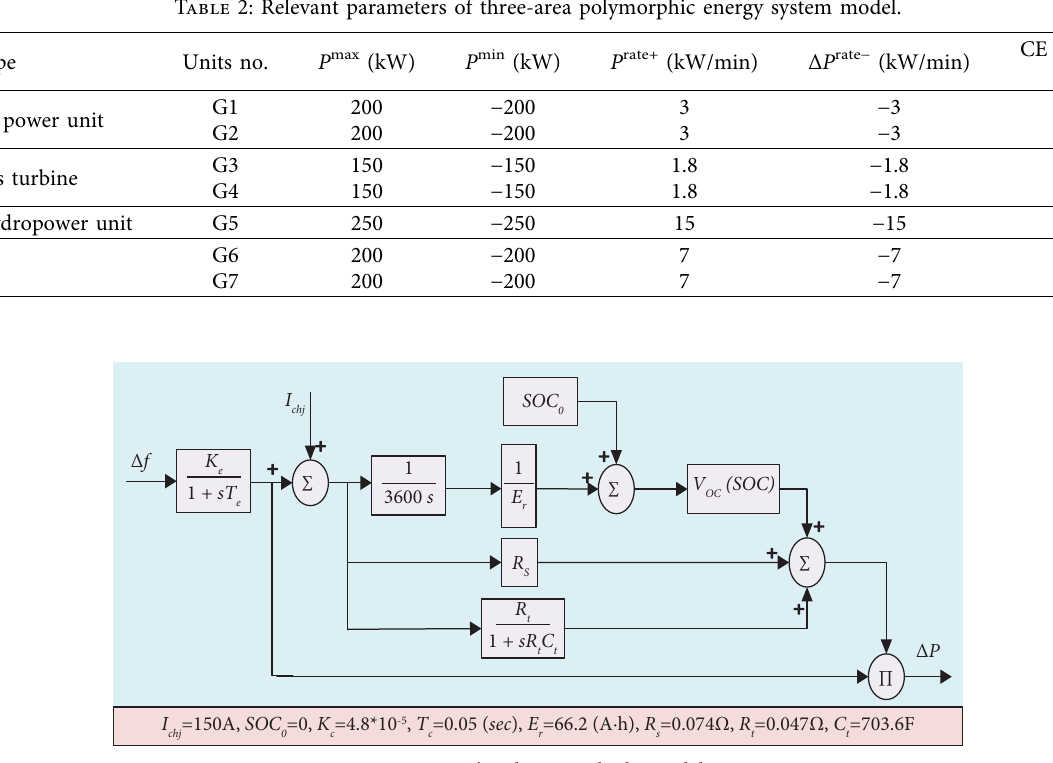
Figure 4: Te electric vehicle